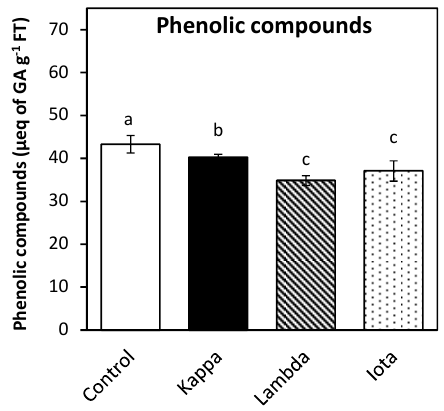
Figure 4. Total phenolic compounds in leaves of control Eucalyptus (control) and in trees treated with OCs kappa, lambda and iota. The amount of total phenolic compounds is expressed in microequivalents of gallic acid per gram of fresh tissue (FT).